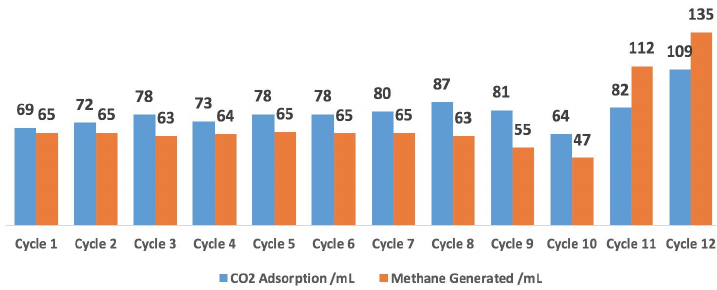
Figure 5. CO 2 adsorption and methanation using 10 grams of the Ru-Na 2 CO 3 DFM (5% Ru, 10% Na 2 CO 3 /Al 2 O 3 ) pellet for the 12-cycle test conducted in the fixed bed reactor in simulated flue gas at 320 °C. Pretreatment of the DFM was conducted with 5% H 2 /N 2 for 150 min before the first cycle. For cycles 2–10, hydrogen exposure was 30 min. Before cycle 11 another 150-min 5% H 2 /N 2 exposure was added, and for cycle 12, 48 h H 2 exposure. The volumes shown in the figure are for CO 2 adsorbed and CH 4 produced. Table 1. Brunauer-Emmett-Teller (BET) specific surface area of the fresh and flue gas cyclic aged Ru- Na 2 CO 3 DFM pellets. Ru crystallite sized for fresh and cyclic aged samples based on H 2 chemisorption assuming H/Ru = 1/1. Sample